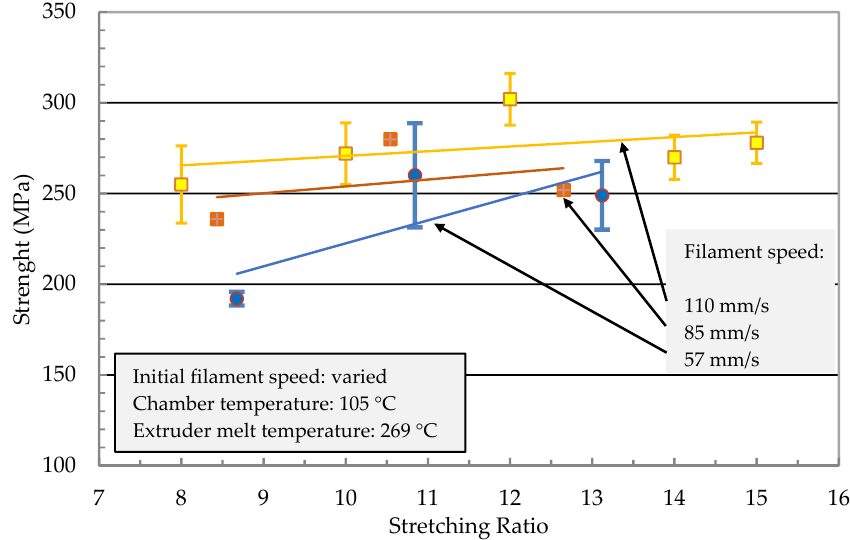
Figure 11. Strength of the stretched PP with 22 wt% PET filaments as a function of the stretching ratio for different initial filament speeds v 1 before entering the chamber.